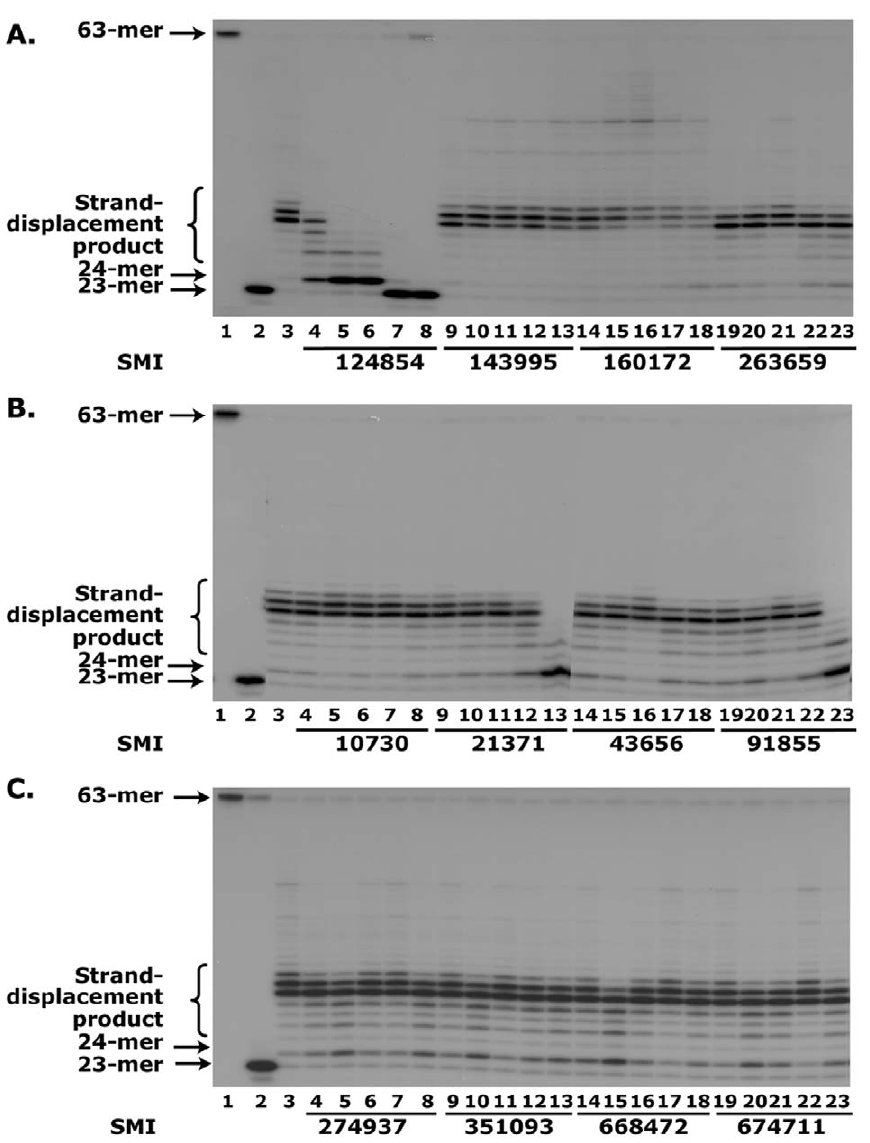
Figure 2. Screening of small molecules. To determine the effect of compounds on the blockage of Pol- b -activity, we assembled in vitro strand- displacement synthesis assay with purified APE1 precut 32 P-labeled 63-mer F-DNA and Pol- b . Panel A (NSC-124854, NSC-143995, NSC-160172 and NSC-263659), B (NSC-10730, NSC-21371, NSC-43656 and NSC-91855) and C (NSC-274937, NSC-351093, NSC-668472 and NSC-674711) show the effect of small molecules on Pol- b -directed strand displacement synthesis. In each Panel, lane 1 shows 63-mer 32 P-labeled F-DNA, lane 2 shows 23-mer product after APE1 incision, lane 3 shows 1-nt incorporation (24-mer) and strand-displacement products. Lanes 4–8, 9–13, 14–18 and 19–23 show the strand-displacement activity of Pol- b incubated with 0, 5, 10, 25, 50 and 125 m M, respectively, of the indicated compounds. Data are representative of two experiments.